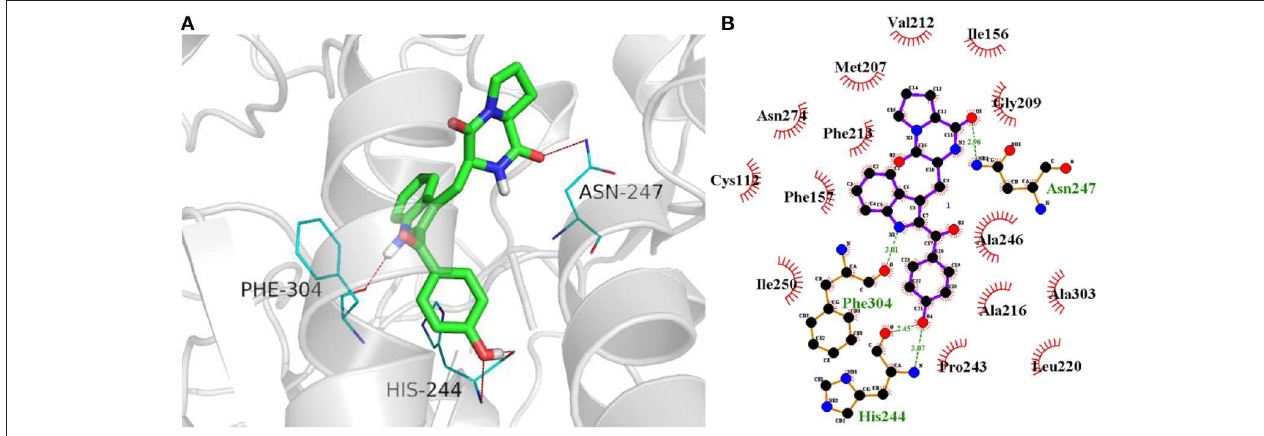
FIGURE 5 | (A) Docking of compound 3c (colored in green) into the active site of FabH (gray, PDB: 1HNJ) via hydrogen bond with Asn247, Phe304, and His244(colored in blue). Likely hydrogen bonds are indicated by red dashed lines (four hydrogen bonds). (B) The details of interactions were displayed by ligplus v1.4.5.